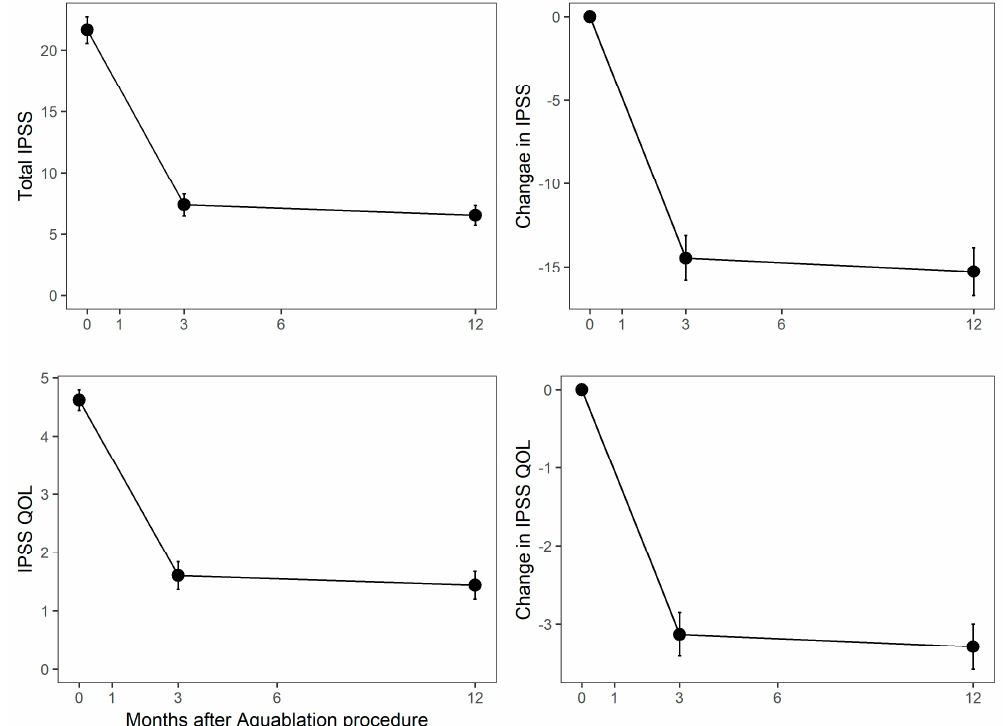
Figure 1. Absolute (y-axis) and change (y-axis) in International Prostate Symptom Score (IPSS) and IPSS QOL. Population means are shown at the left and score changes at the right. Months after Aquablation procedure is the y-axis in all graphs.